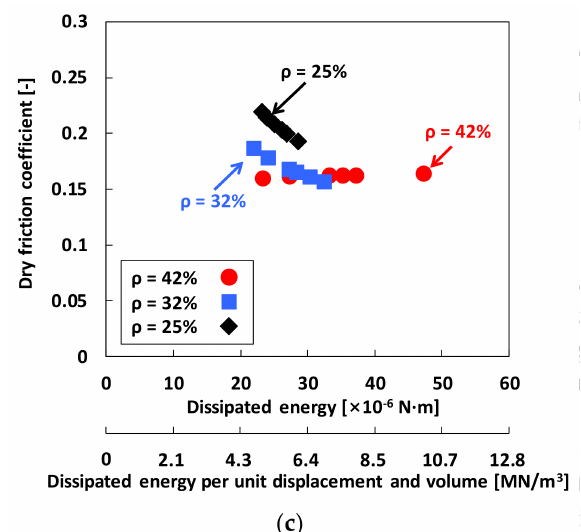
Figure 13. Local hysteresis loop measurements: Estimated dry friction coefficients µ f versus ( a ) preload F Pre (upper horizontal axis) and preload F Pre per unit volume of WMD (lower horizontal axis), ( b ) local stiffness K Local (upper horizontal axis) and local stiffness K Local per unit volume of WMD (lower horizontal axis), and ( c ) dissipated energy E dis (upper horizontal axis) and dissipated energy E dis per unit displacement and volume of WMD (lower horizontal axis). The circle, square, and diamond symbols denote loss factors of the WMDs with 42%, 32%, and 25% densities,